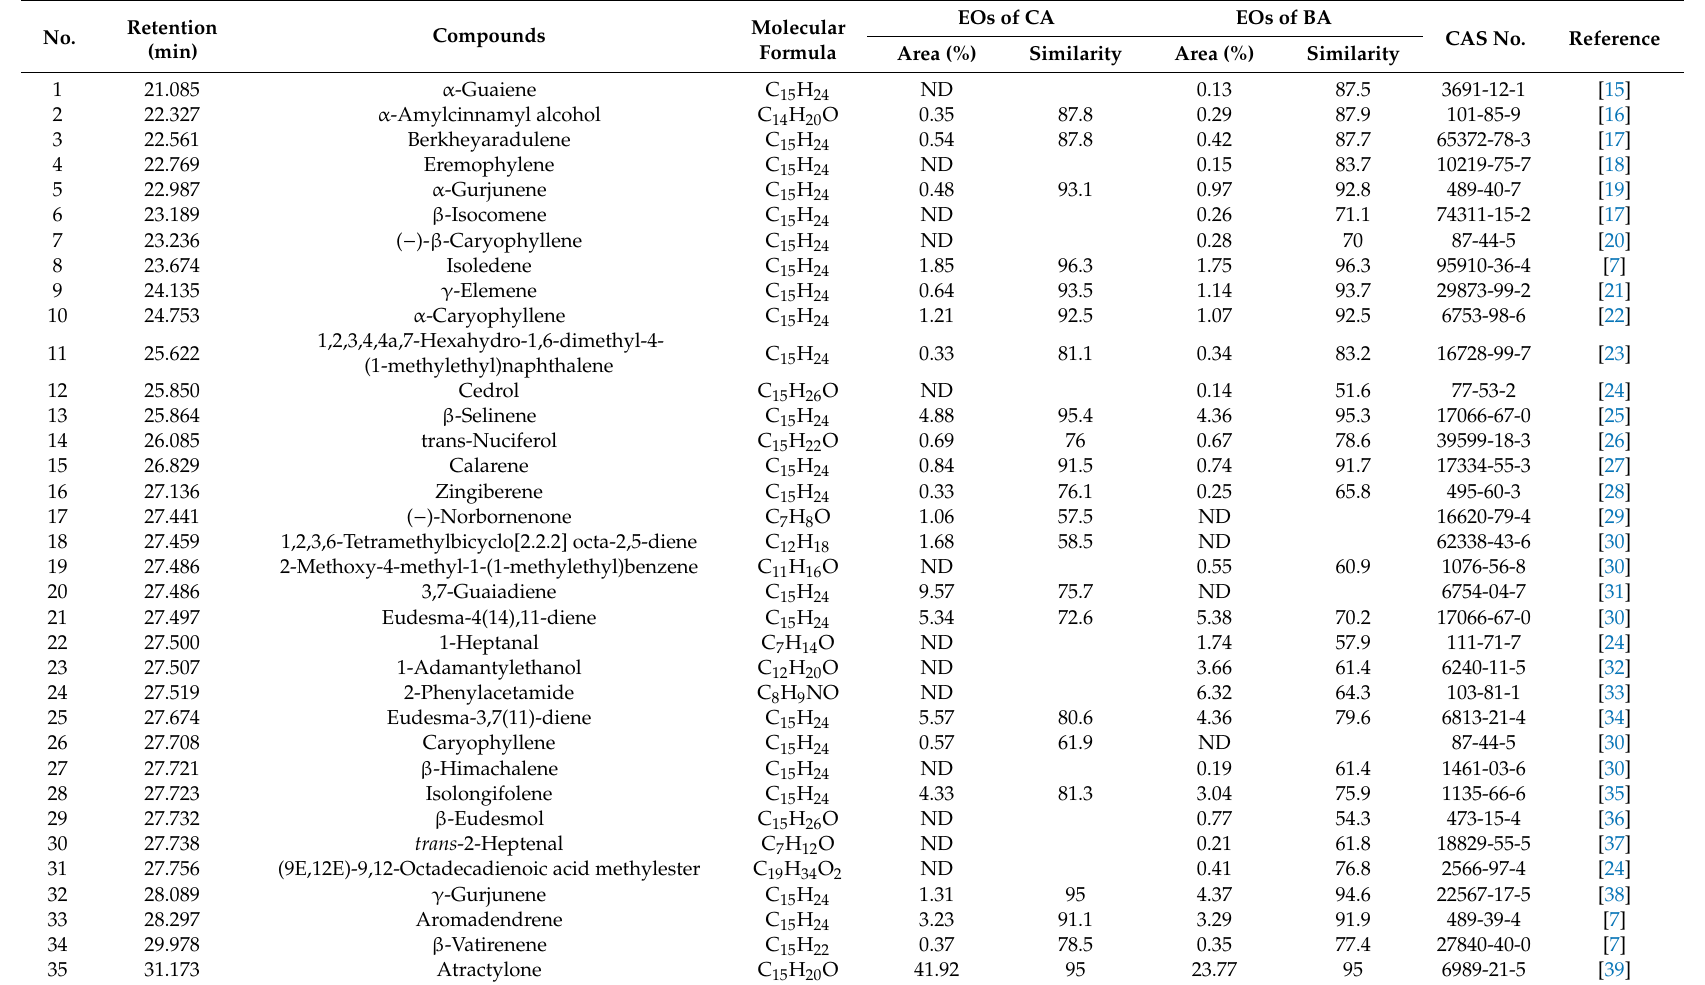
Table 1. Chemical compositions and content * of the EOs of CA and